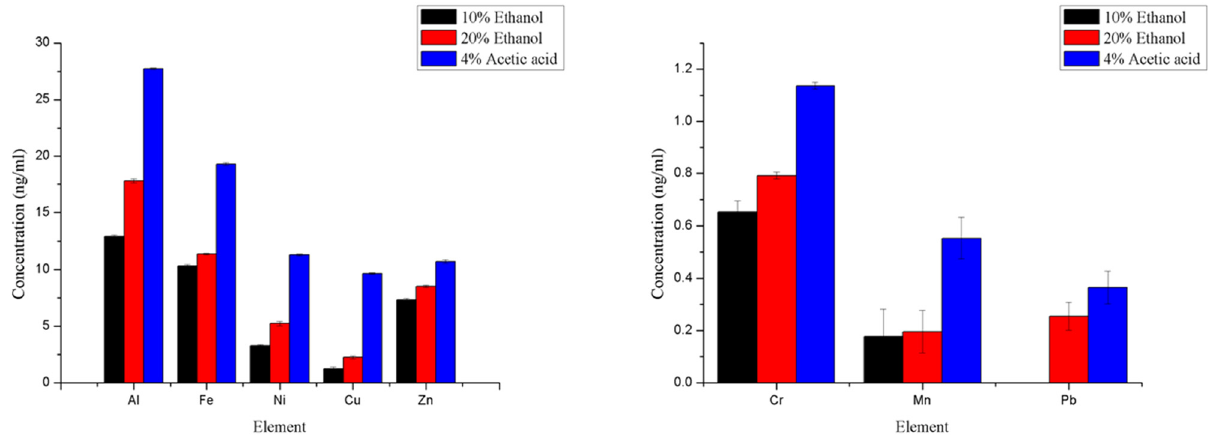
Figure 2: E ff ect of di ff erent acidity solvent on the concentration of each element in